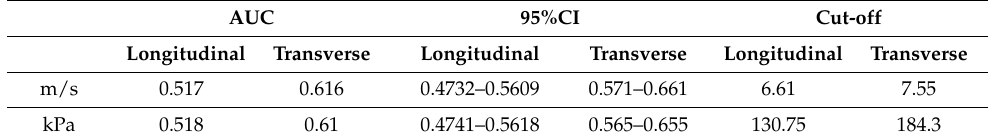
Different letters in the same row indicate significantly different results ( p < 0.05). Table 5. Area under the curve (AUC) of the ROC curve for each variable. 95% CI (Confidence Interval) and optimal cut-off value are also shown. AUC 95%CI Cut-off